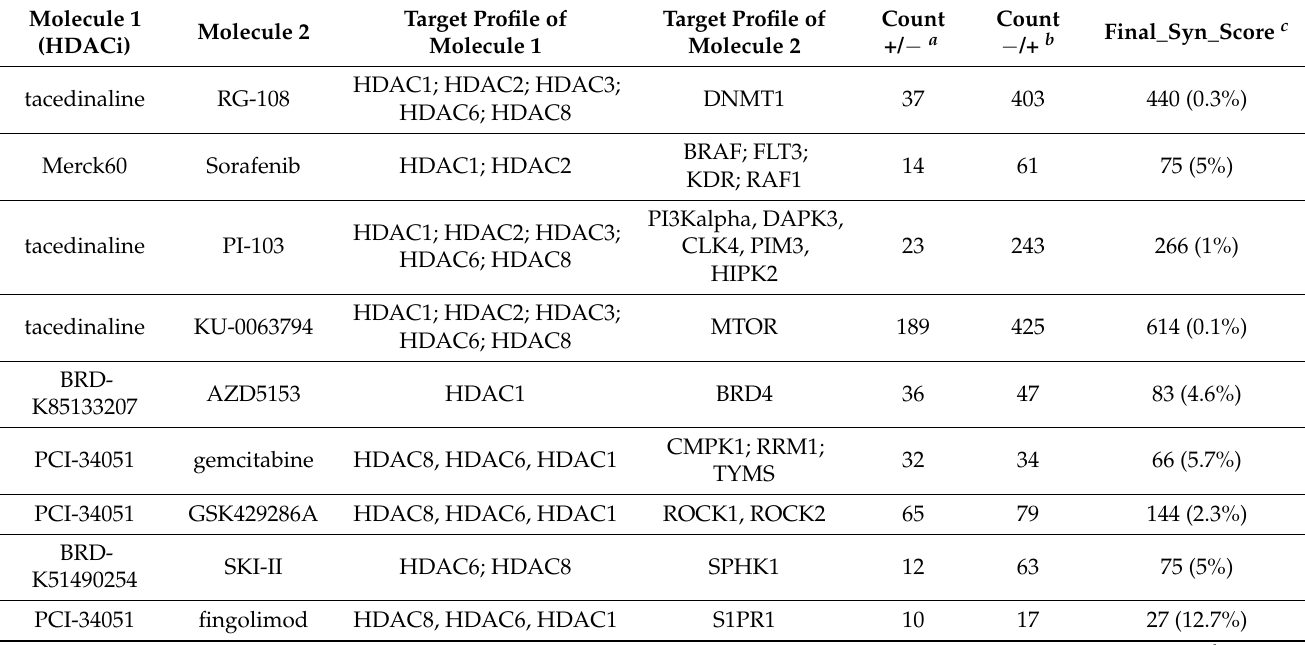
Table 1. Results of HDACi synergy predictions with known literature